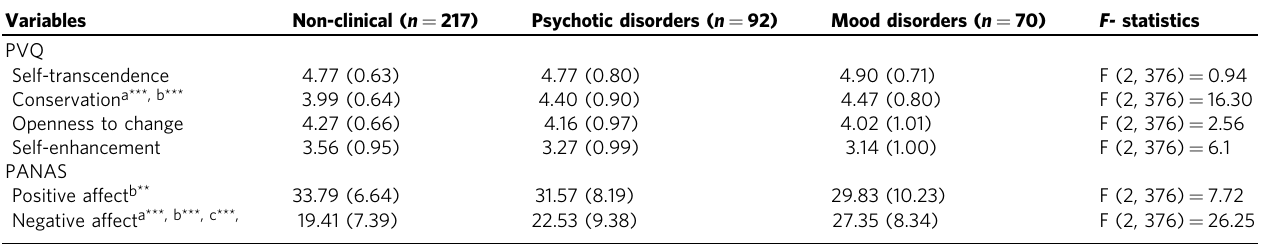
Descriptive values are reported as non-transformed values. ANOVA results were computed on squared-transformed values. PVQ Portrait Values Questionnaire, PANAS Positive and Negative Affect